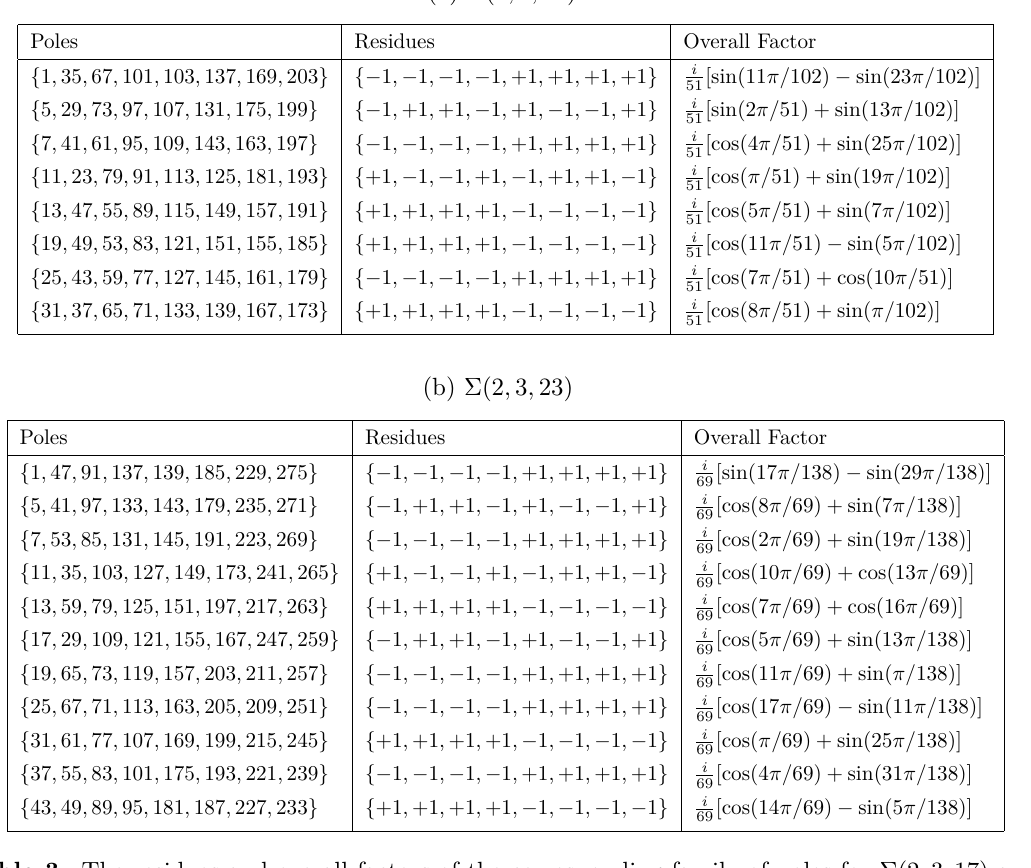
Table 3. The residues and overall factors of the corresponding family of poles for Σ(2 , 3 , 17) and Σ(2 , 3 , 23)